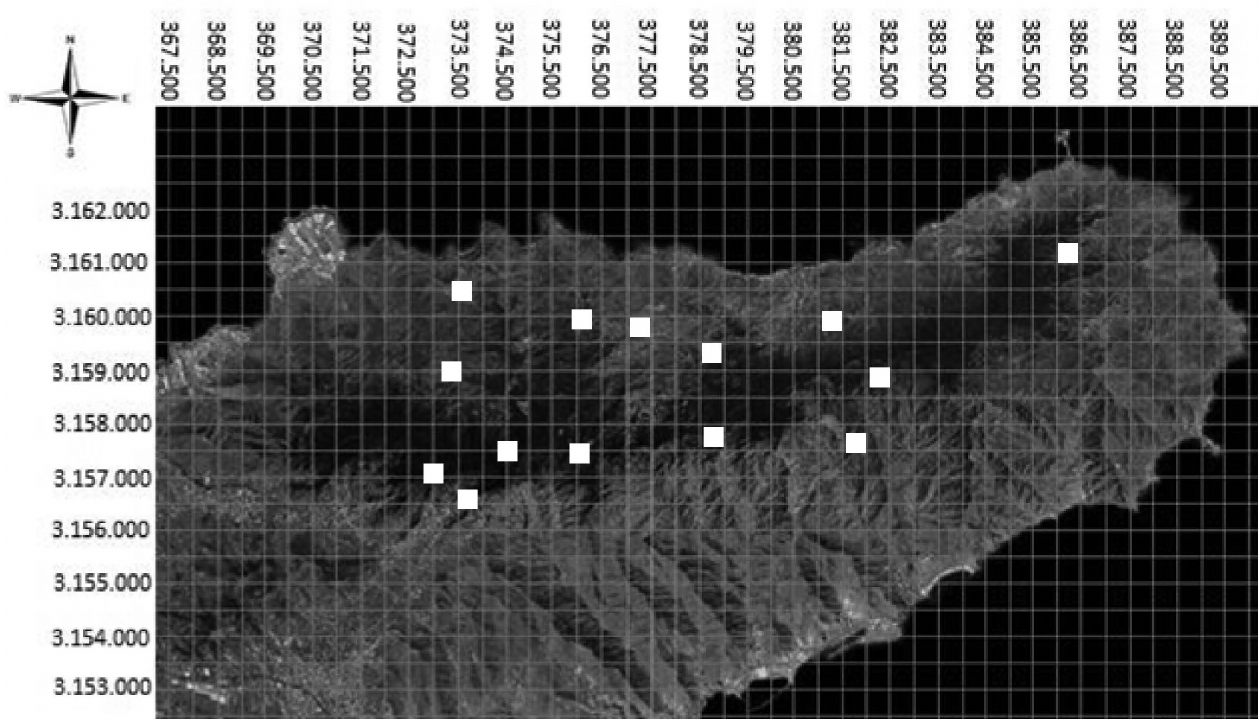
Figure 3 – Map showing the localities prospected (UTM coordinates) for the study and inventory of exotic plants in Anaga Rural Park (Tenerife, Canary